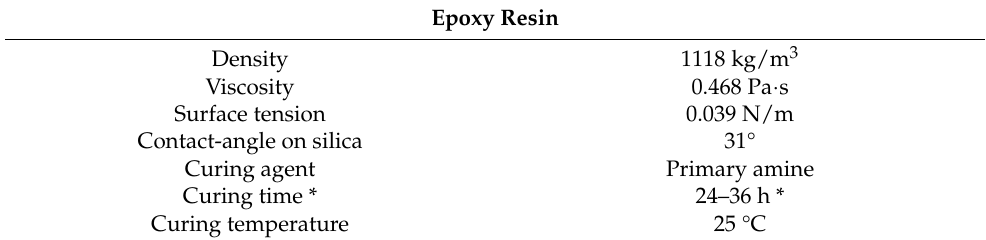
Table 2. Epoxy resin properties.